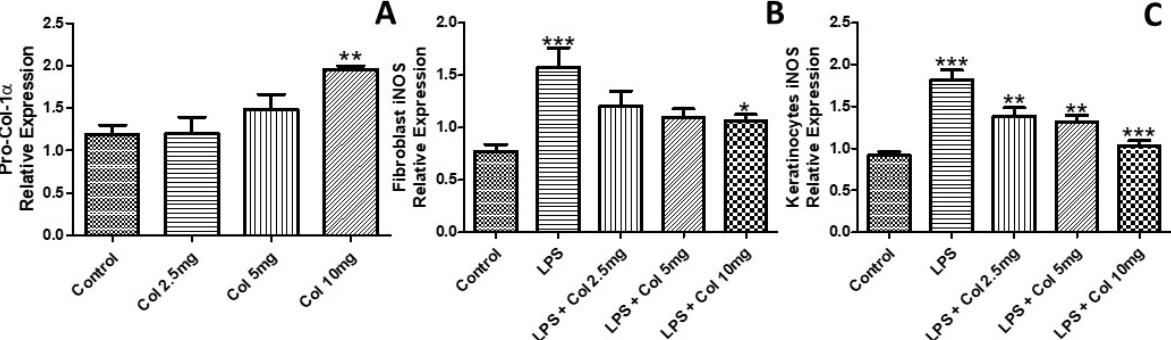
Figure 2. The effects of collagen supplementation on human fibroblasts synthesis of pro-collagen- 1α ( A ) and on the expression of inducible nitric oxide synthase (iNOS) on fibroblasts ( B ) and ( C ). For ( A ), ** p < 0.01 compared with the control group. For ( B ), * p < 0.05 compared with the control and LPS groups; *** p < 0.001. For ( C ), *** p < 0.001 compared with the control and LPS groups